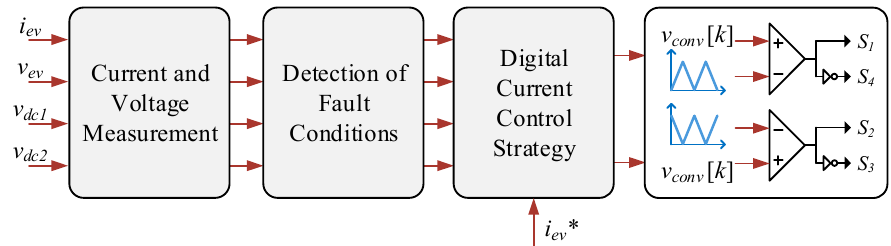
Figure 3. Block diagram of the control strategy applied to the bidirectional multilevel dc–dc power converter.